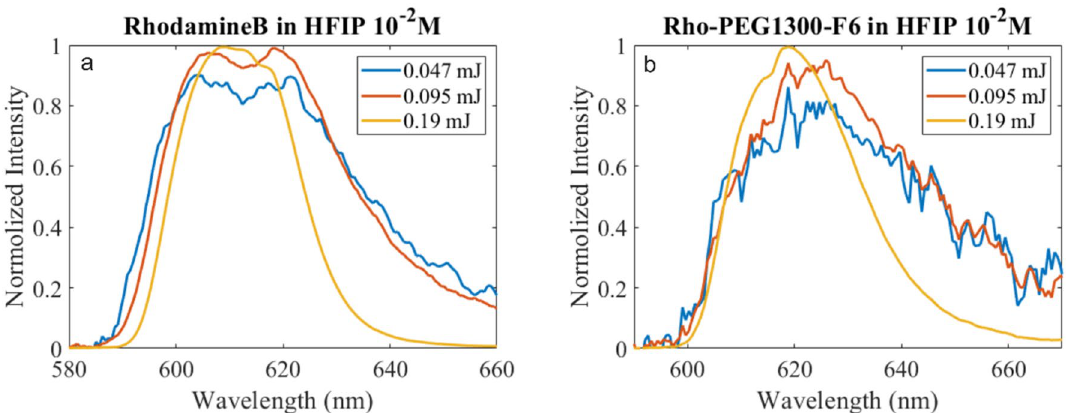
Figure 5. Spectral narrowing of the fluorescence—normalized fluorescent spectra of optically pumped samples. ( a ) Rhodamine B and ( b ) Rho-PEG1300-F6 at 10 −2 M concentration. Energies per pulse of the pump are indicated in the legends.